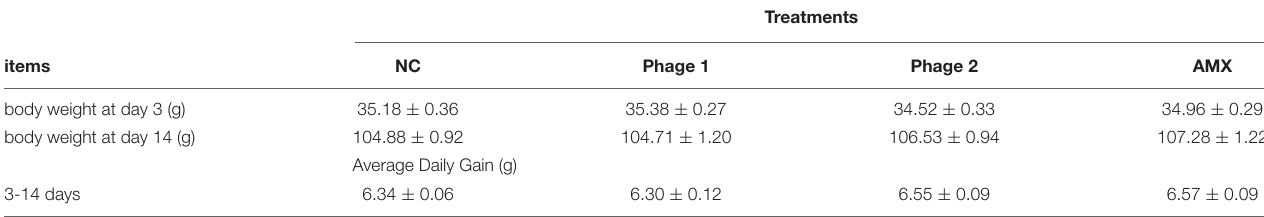
TABLE 2 | Effect of phage on body weight of